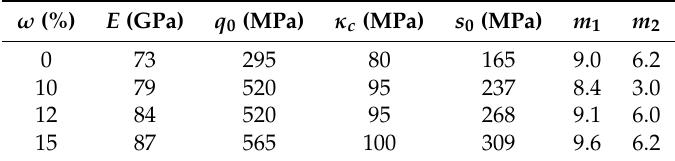
Table 1. Parameter values changing with the weight percentage.